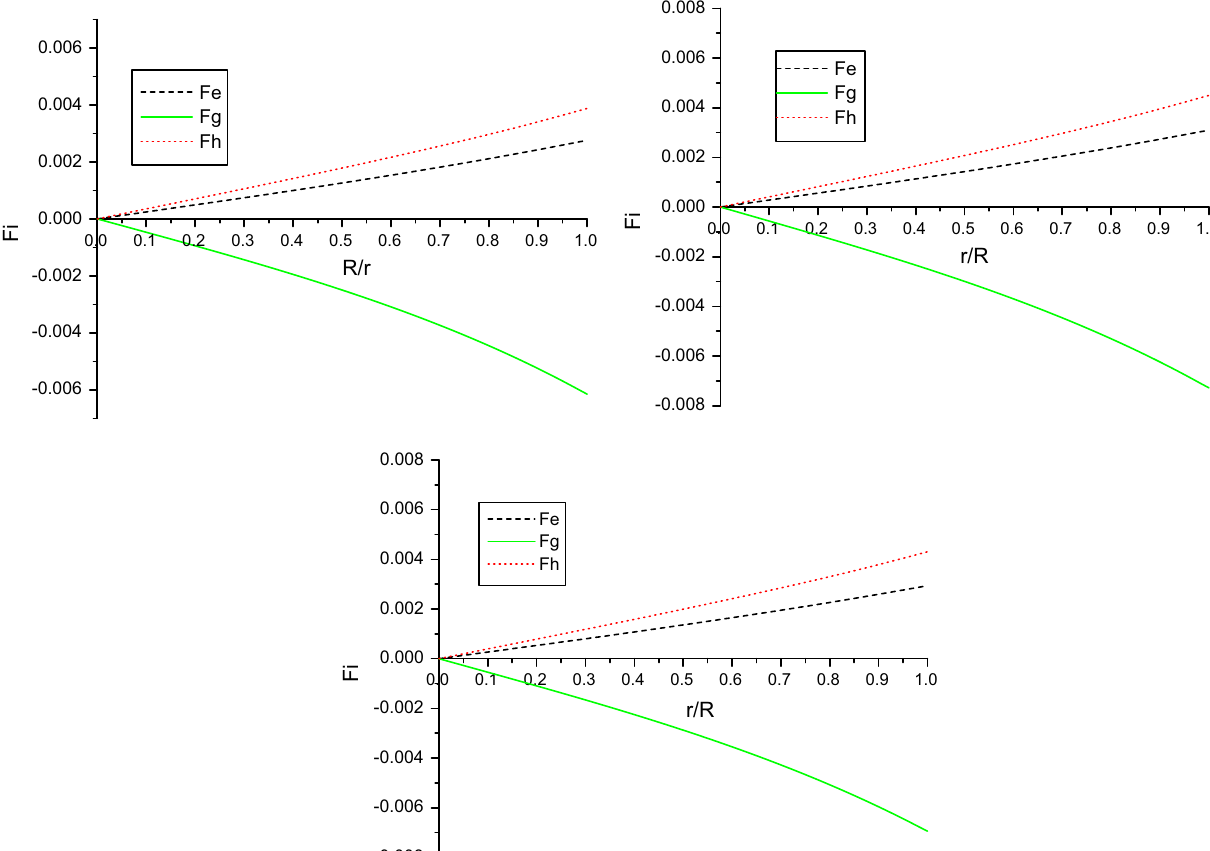
gravitational force is dominated by hydrostatic and electric forces to maintain the equilibrium condition. We follow the same procedure for finding solutions as given in Fig.